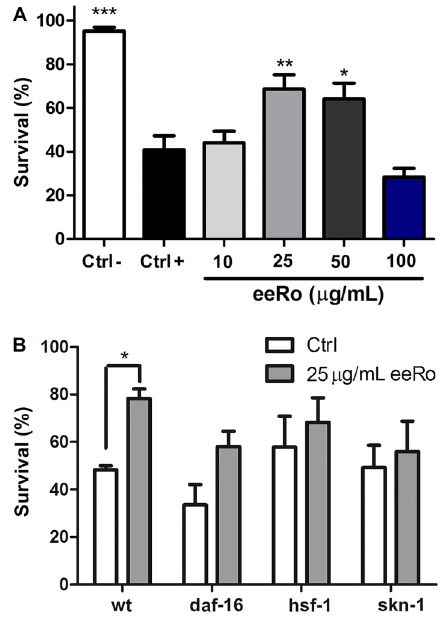
Figure 2. Effect of ethanolic extract of Rosmarinus of fi cinalis L. (eeRo) on thermal stress. Survival of wild-type ( A ) and mutant worms ( B ) treated with eeRo and exposed to thermal stress (35°C) for 4 h (Ctrl + ). Data are reported as percentage of living worms of 100 worms in each experiment from 4 independent assays. A , *P o 0.05, **P o 0.01, ***P o 0.001, compared to the Ctrl + group (one-way ANOVA). B , *P o 0.05 (two-way